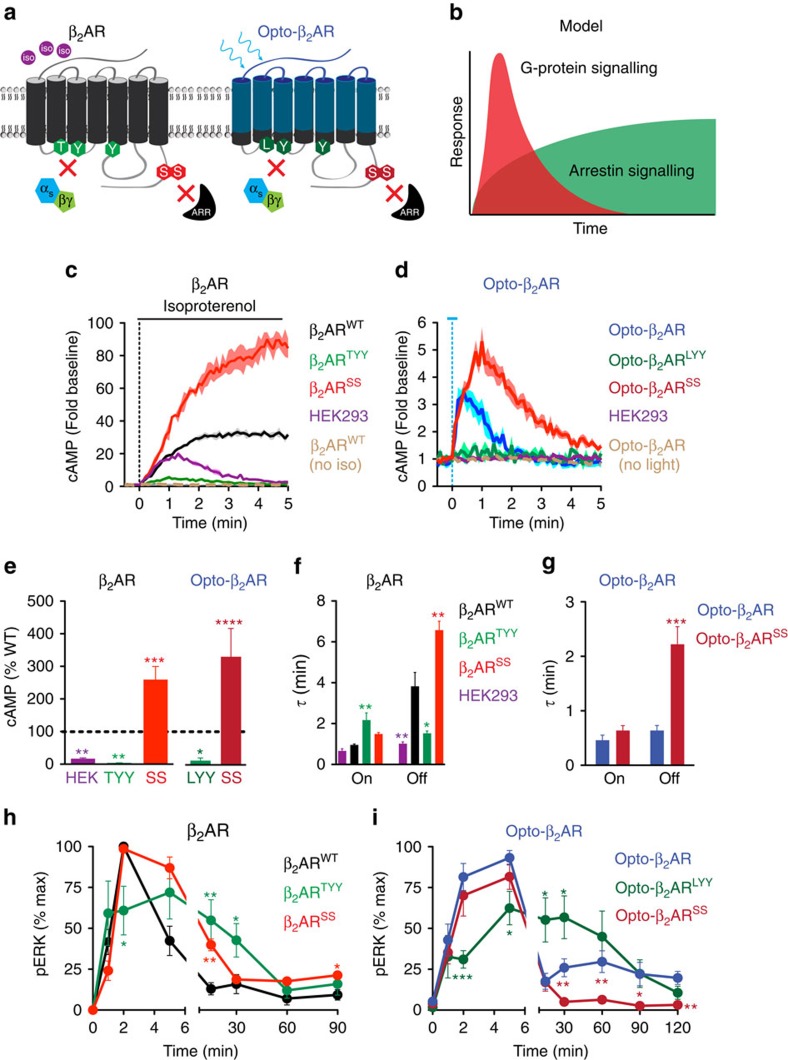
Mutations of β2AR and opto-β2AR alter intracellular signaling kinetics.(a) Schematic of point mutations. (b) Model of G-protein and arrestin / MAP kinase signaling10. (c) Isoproterenol-induced (1 μM) cAMP kinetics of β2ARWT (black; n=3), β2ARTYY (green; n=3), β2ARSS (red; n=3) and HEK293 cells (purple; n=3). β2ARWT with no isoproterenol (dashed brown; n=3; mean=solid line, s.e.m.=shaded area). (d) Light-induced (5 s) cAMP kinetics of opto-β2AR (dark blue; n=8), opto-β2ARLYY (dark green; n=5) and opto-β2ARSS (dark red; n=5). HEK293 controls and opto-β2AR with no light (dashed brown; n=3) (mean=solid line, s.e.m.=shaded area). (e) β2ARTYY (green; n=3), opto-β2ARLYY (dark green; n=5), HEK293 cells (purple; n=3), β2ARSS (red; n=3) and opto-β2ARSS (dark red; n=5) cAMP compared with WT (*P<0.05, **P<0.01, ***P<0.001, ****P<0.0001 via one-way ANOVA followed by Dunnett's multiple comparison test to WT). (f) Time constants of isoproterenol (1 μM)-induced cAMP of β2ARWT (black; n=3), β2ARTYY (green; n=3), β2ARSS (red; n=3) and HEK293 cells (purple; n=3) (*P<0.05, **P<0.01 via One Way ANOVA followed by Dunnett's multiple comparison test to WT). (g) Time constants of light (5 s pulse)-induced cAMP activation of opto-β2AR (dark blue; n=8) and opto-β2ARSS (dark red; n=5) (***P<0.001 via Student's unpaired, two-tailed t-tests to WT). (h) Time course of isoproterenol (1 μM)-induced pERK in β2ARWT (black; n=5), β2ARTYY (green; n=4) and β2ARSS (red; n=3) (*P<0.05, **P<0.01 via Student's unpaired, two-tailed t-tests to WT). (i) Time course of light (1 min)-induced pERK in opto-β2AR (dark blue; n=9), opto-β2ARLYY (green; n=8) and opto-β2ARSS (red; n=9; *P<0.05, **P<0.01, ***P<0.001 via Student's unpaired, two-tailed t-tests to WT). All data expressed as mean±s.e.m.